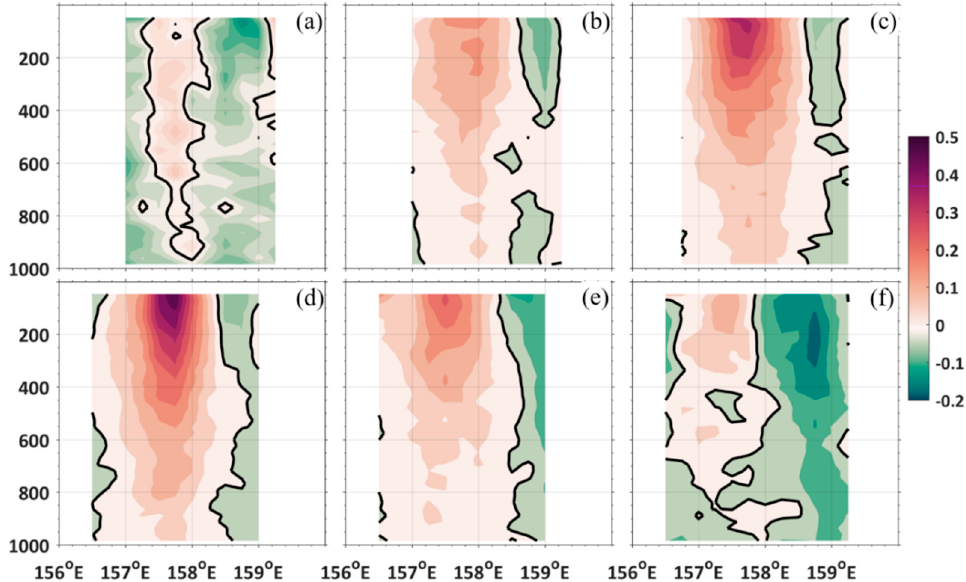
Figure 13. Vertical relative vorticity scaled by the planetary vorticity. ( a ), ( b ), ( c ), (d), ( e ) and ( f ) are for the sections of S1, S2, S3, S4, S5 and S6, respectively. The black line is the zero contour.